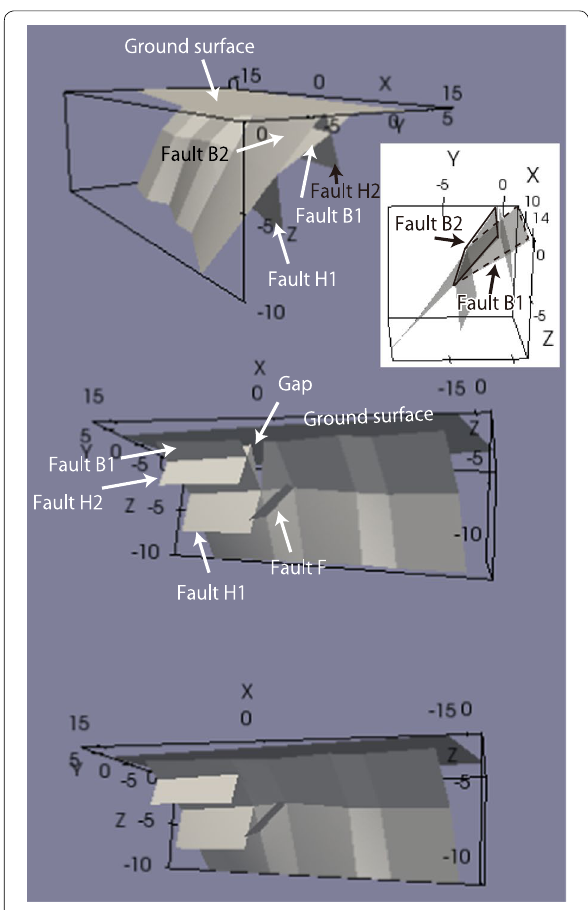
Fig. 5 Fault geometry models. View from northeast (top), looking up from southwest for Model S (middle) and for Model C (bottom). The major branch faults are, respectively, called Fault F located at the center, Faults B1 and B2 for the relatively lower and higher angle ones at the shallow depth of the northern segment. The inset highlights the locations of Faults B1 and B2 enclosed by the solid and dashed lines, respectively. The back-thrust faults called Faults H1 and H2 are also assumed at the northern part. The primary fault is connected to Fault B1 in Model C by filling the gap in Model S. The X -axis is directed to